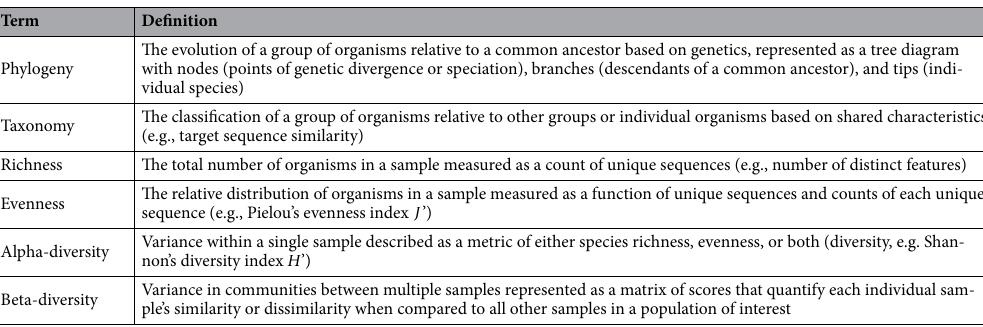
Table 1. Glossary of microbial analysis